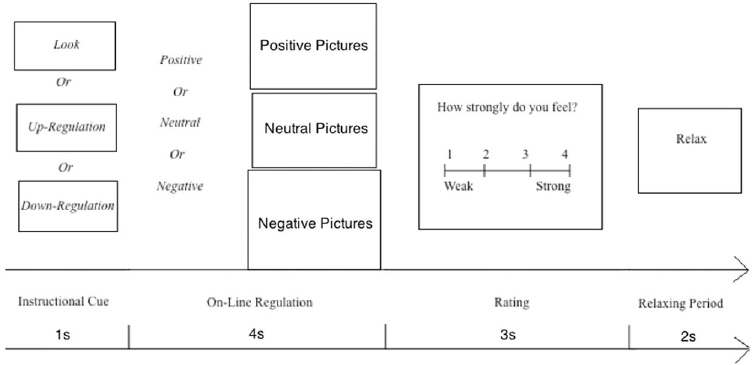
Figure 1. Procedure of Each